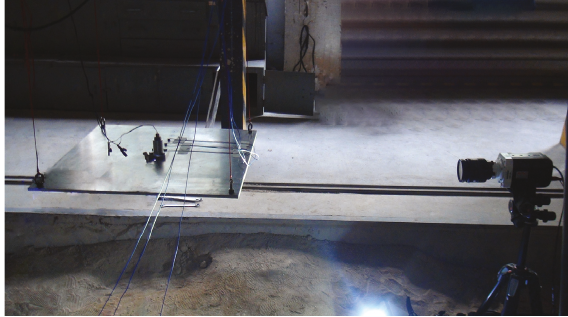
Figure 4: Measurement scene for separation